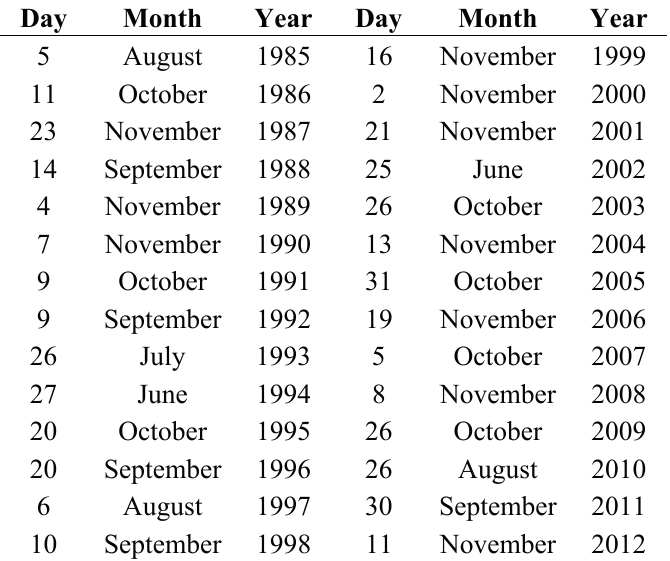
Table 1. Days for which Landsat Climate Data Record (CDR) data are